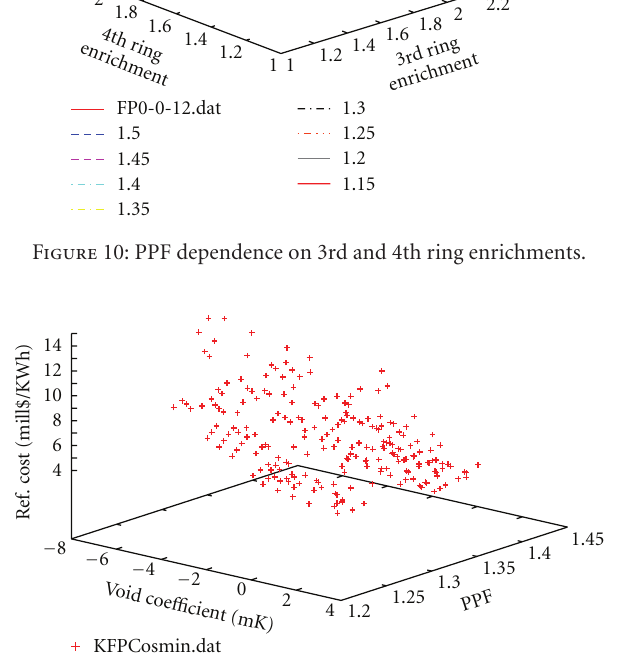
Figure 11: Phase space representation of the calculated configura-